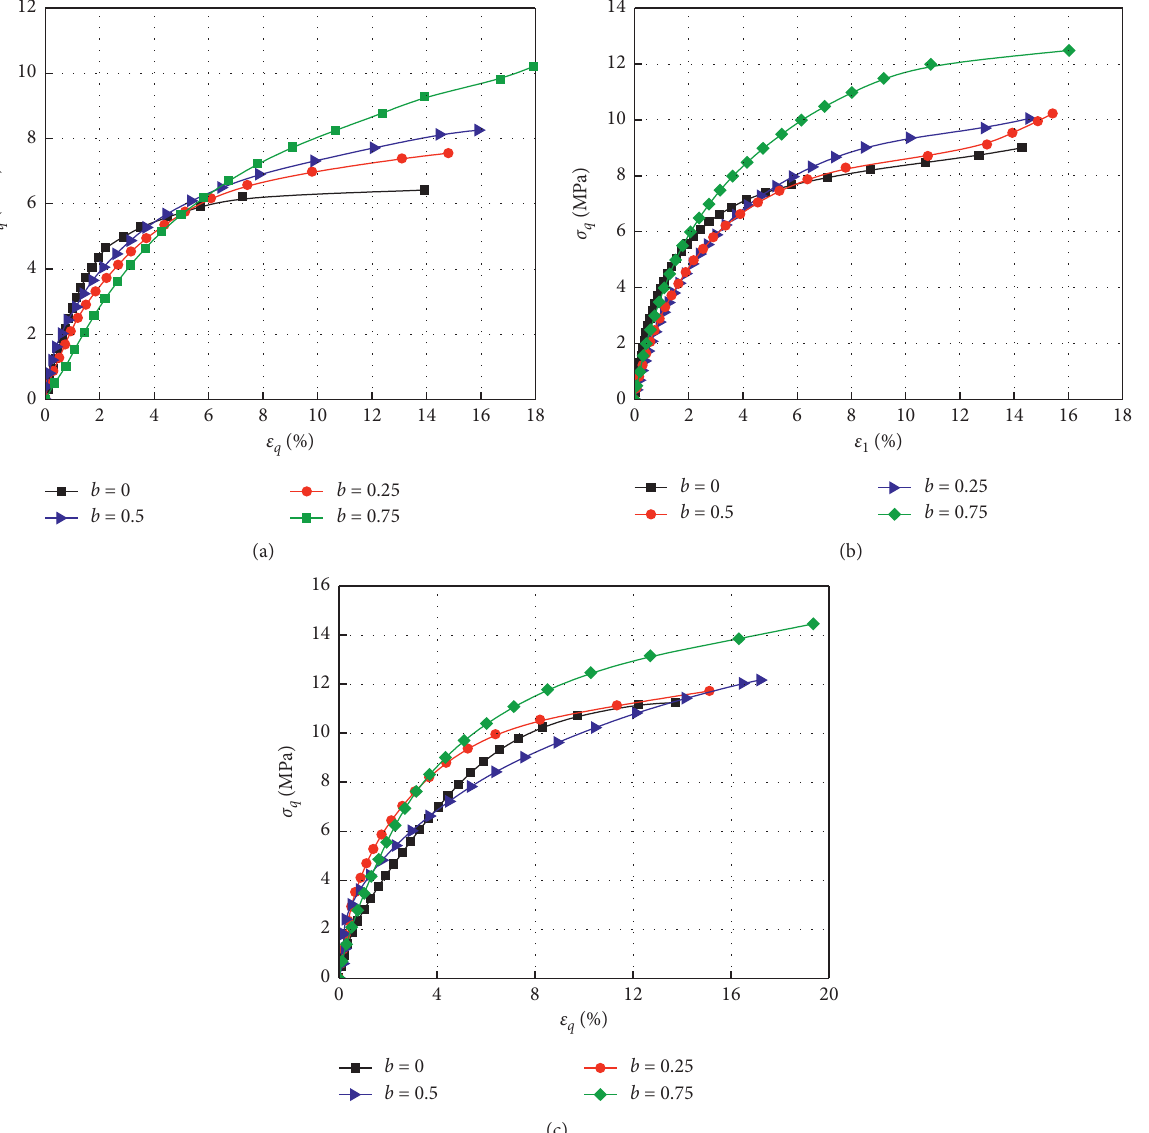
Figure 7: Relationship between generalized shear stress and generalized shear strain of frozen sand at different temperatures. (a) − 5 ° C. (b) − 10 ° C. (c) − 15 °